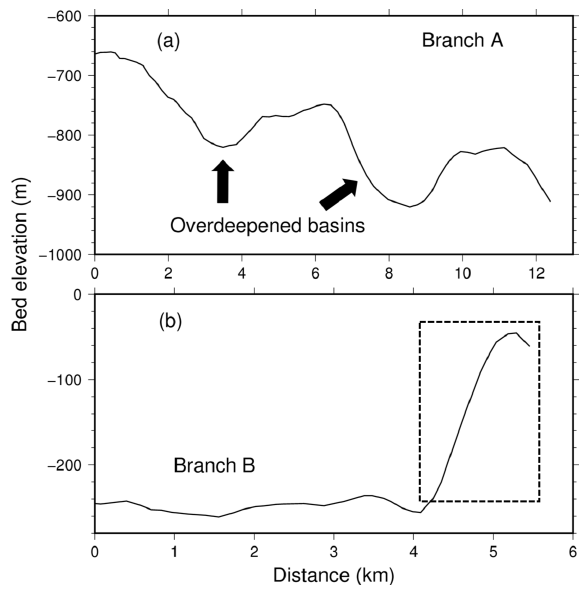
Figure 8. Bed elevation profiles of two branches derived from Bed- Machine v3 (Morlighem et al., 2017). The profile locations are shown in Fig. 1a. The dashed box shows the zone where the bed slopes uphill